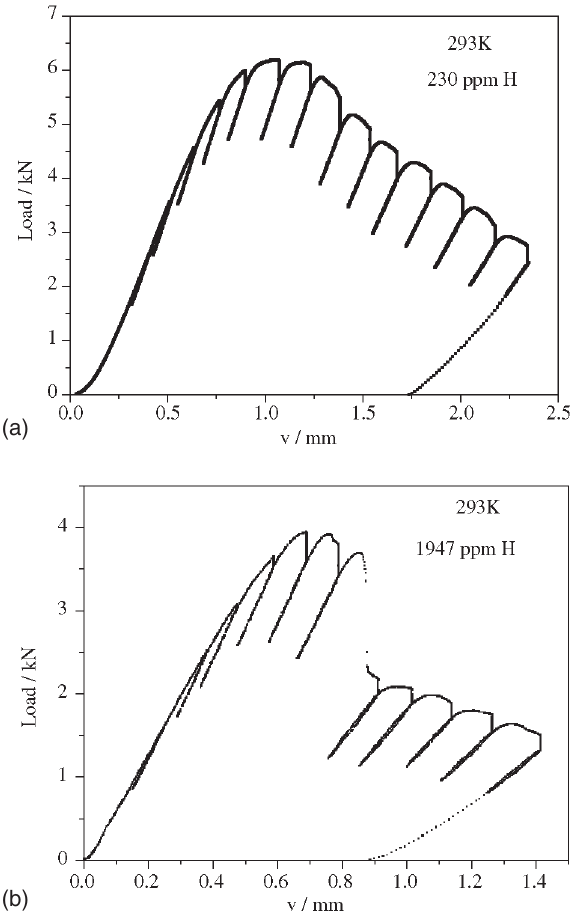
Figure 3. a) Negative crack growth correction on a J-R curve.